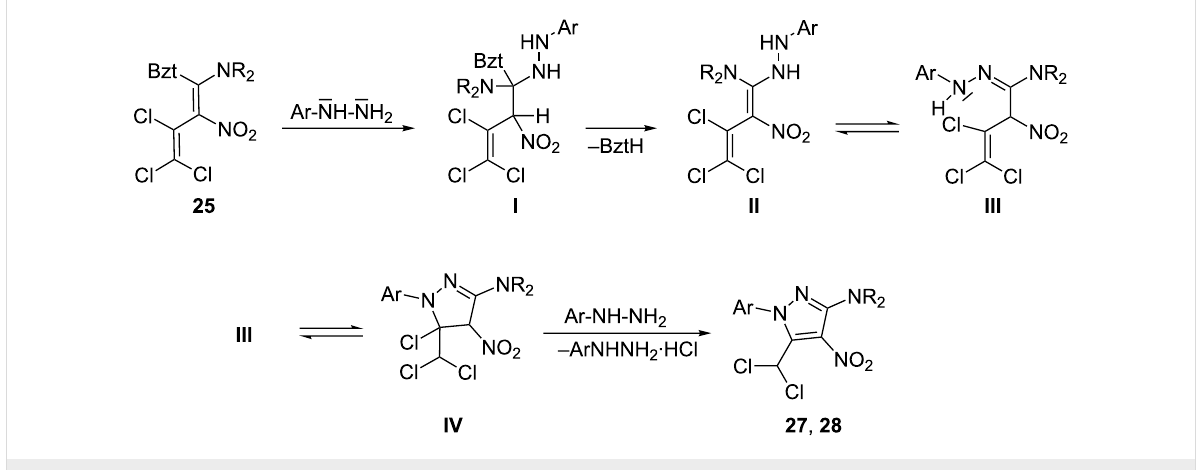
Scheme 7: Proposed reaction mechanism for the formation of 27 , 28 .